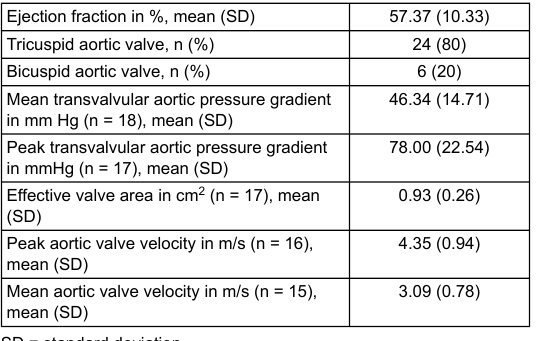
Table 2: Preoperative echocardiographic results (n = 30).